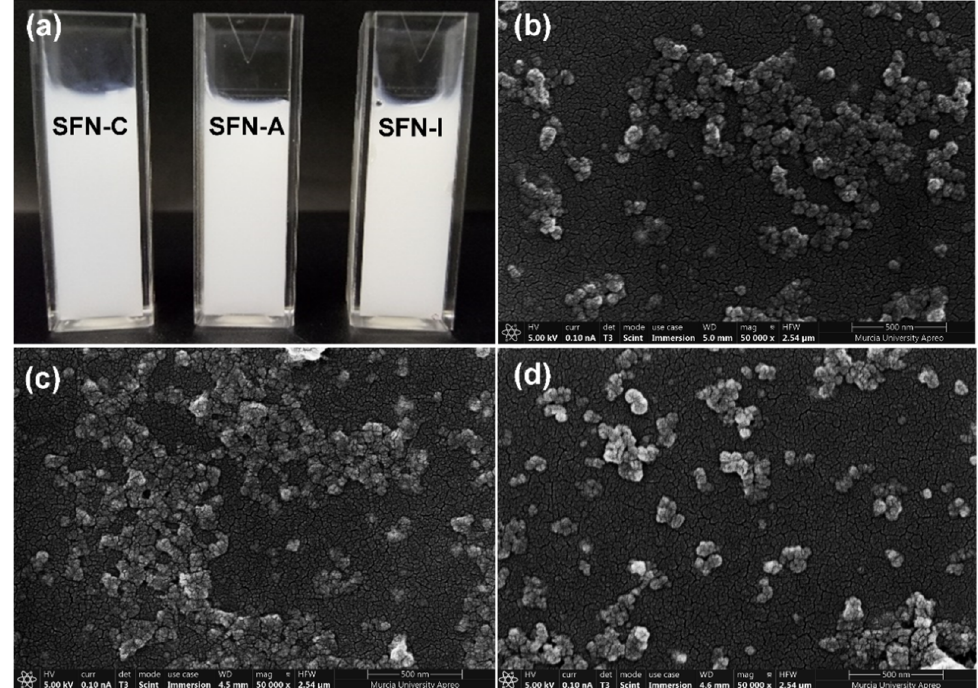
Figure 1. ( a ) Photograph of the non-sterilized (SFN-C), autoclaved (SFN-A), and gamma irradiated at 5 kGy (SFN-I) nanoparticle suspensions at 10 mg/mL in ultrapure water; FESEM images of: ( b ) SFN-C; ( c ) SFN-A, and ( d ) SFN-I. Scale bar = 500 nm.